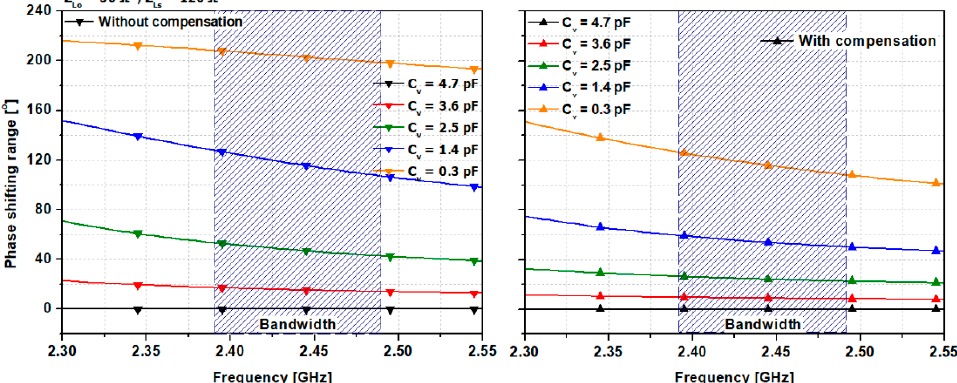
Figure 7. PSR with and without compensating for the effects of a λ /4 shunt open stub at the high band.